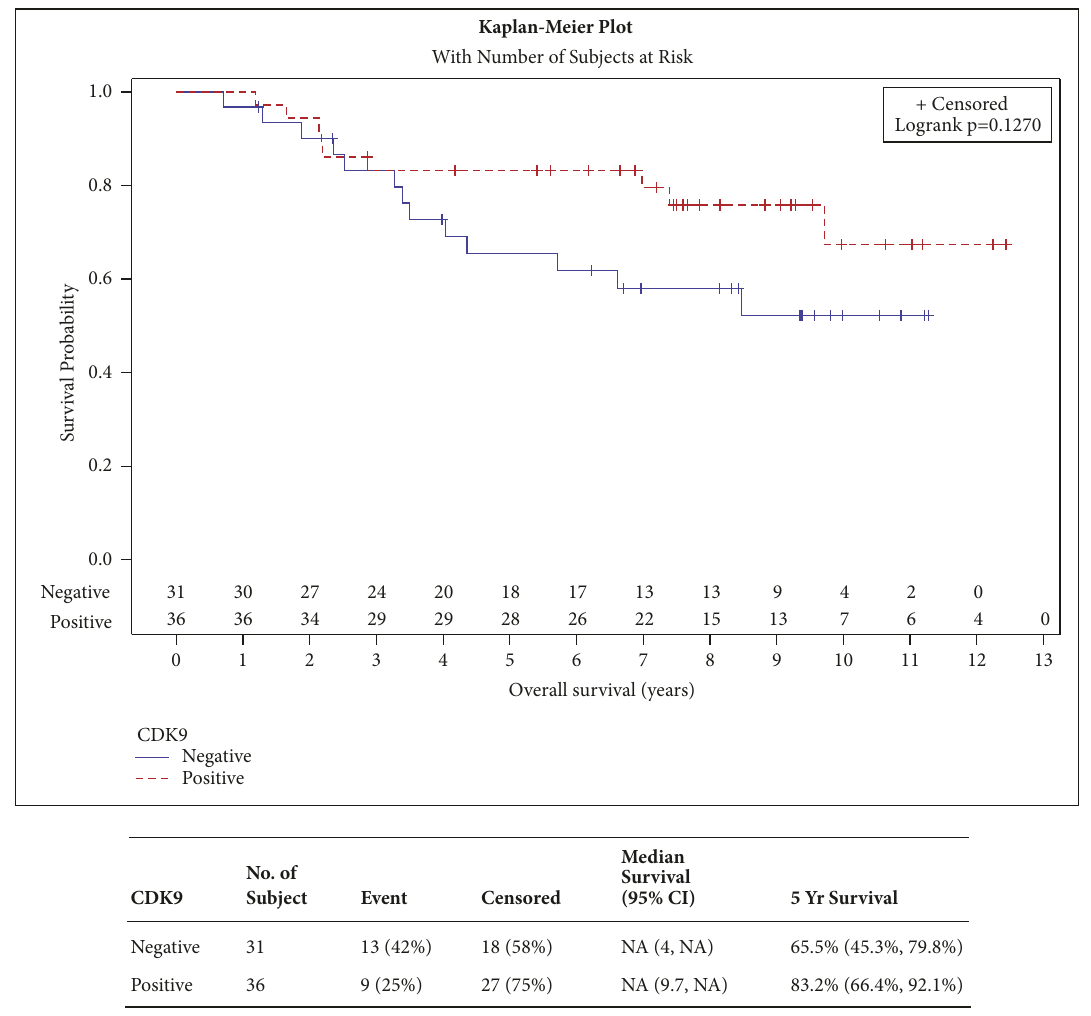
Figure 1: O verall survival . Figure 1 depicts the overall survival curves for patients with CDK9 positive versus CDK9 negative tumors. This shows a statistically nonsignificant difference in survival. However, there is a trend for increased overall survival in the group of patients with positive